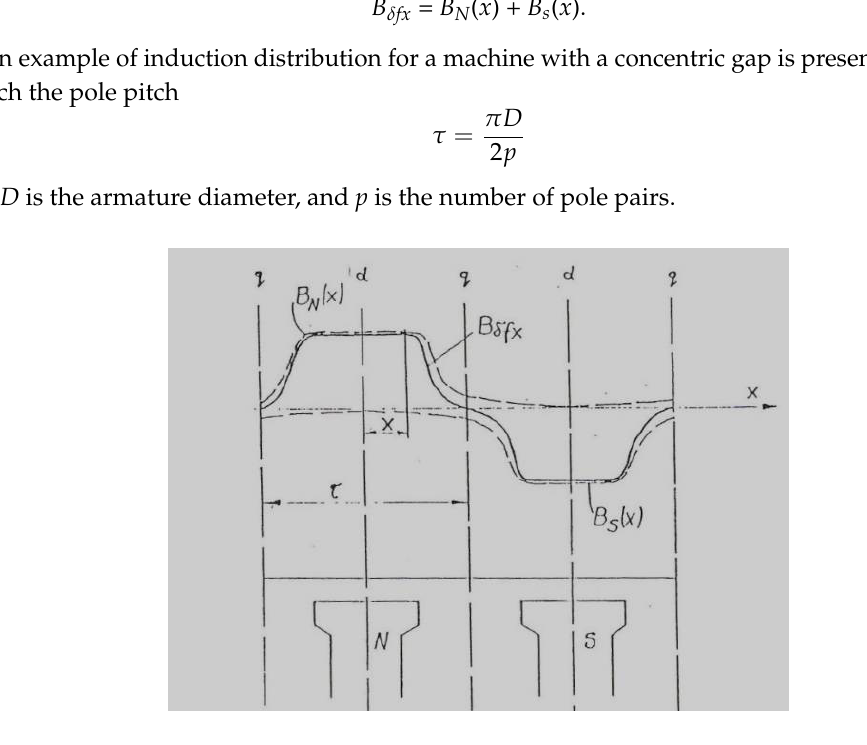
Figure 2. Distribution of magnetic induction from excitation winding on the outspread circuit of the machine with a commutator gap.